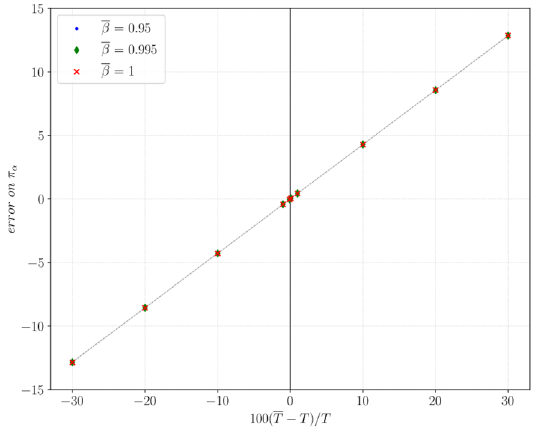
Figure 9. Percentage variation of AoI α for λ = 1/1800 s − 1 , β = 0.95 (circles), β = 0.995 (diamonds), β = 1 (crosses).